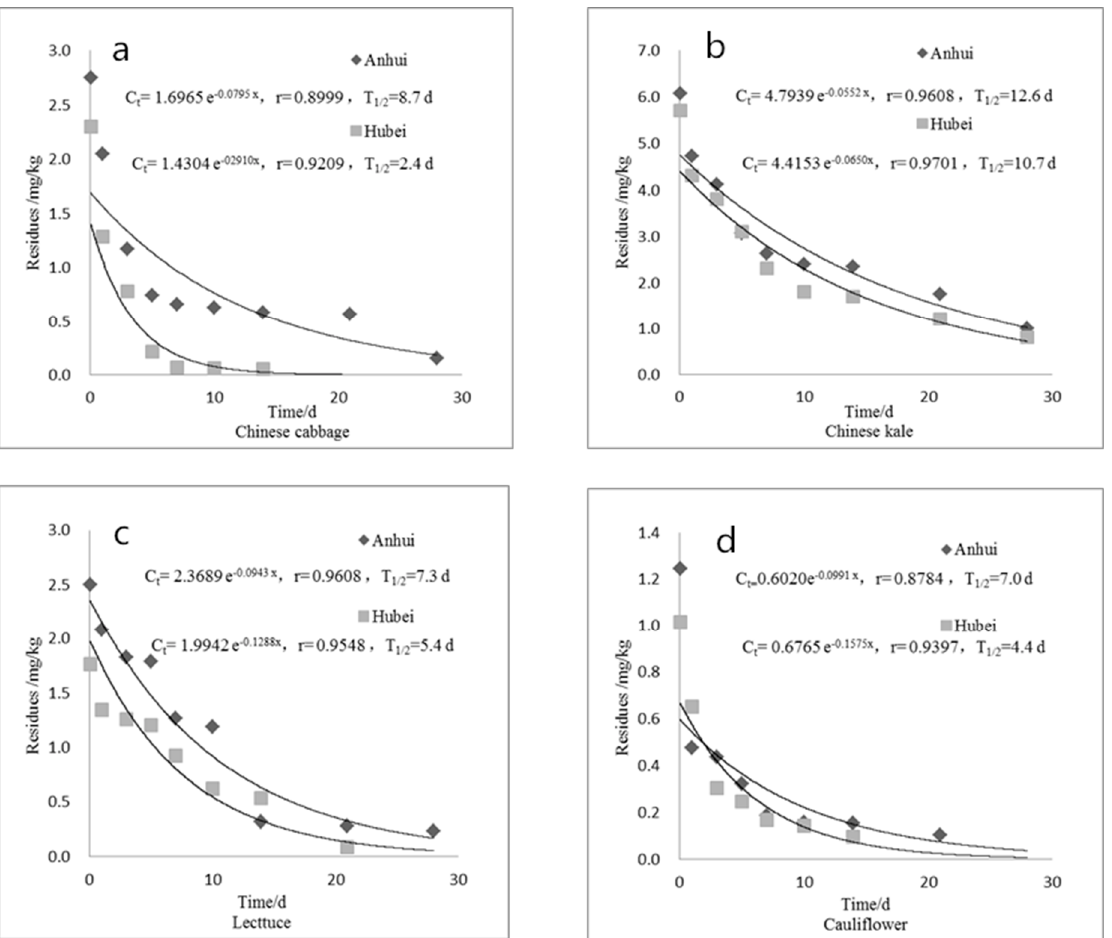
Figure 4. Dissipation kinetics of chlorfluazuron in Chinese cabbage ( a ); Chinese kale ( b ); lettuce ( c ); and cauliflower ( d ).